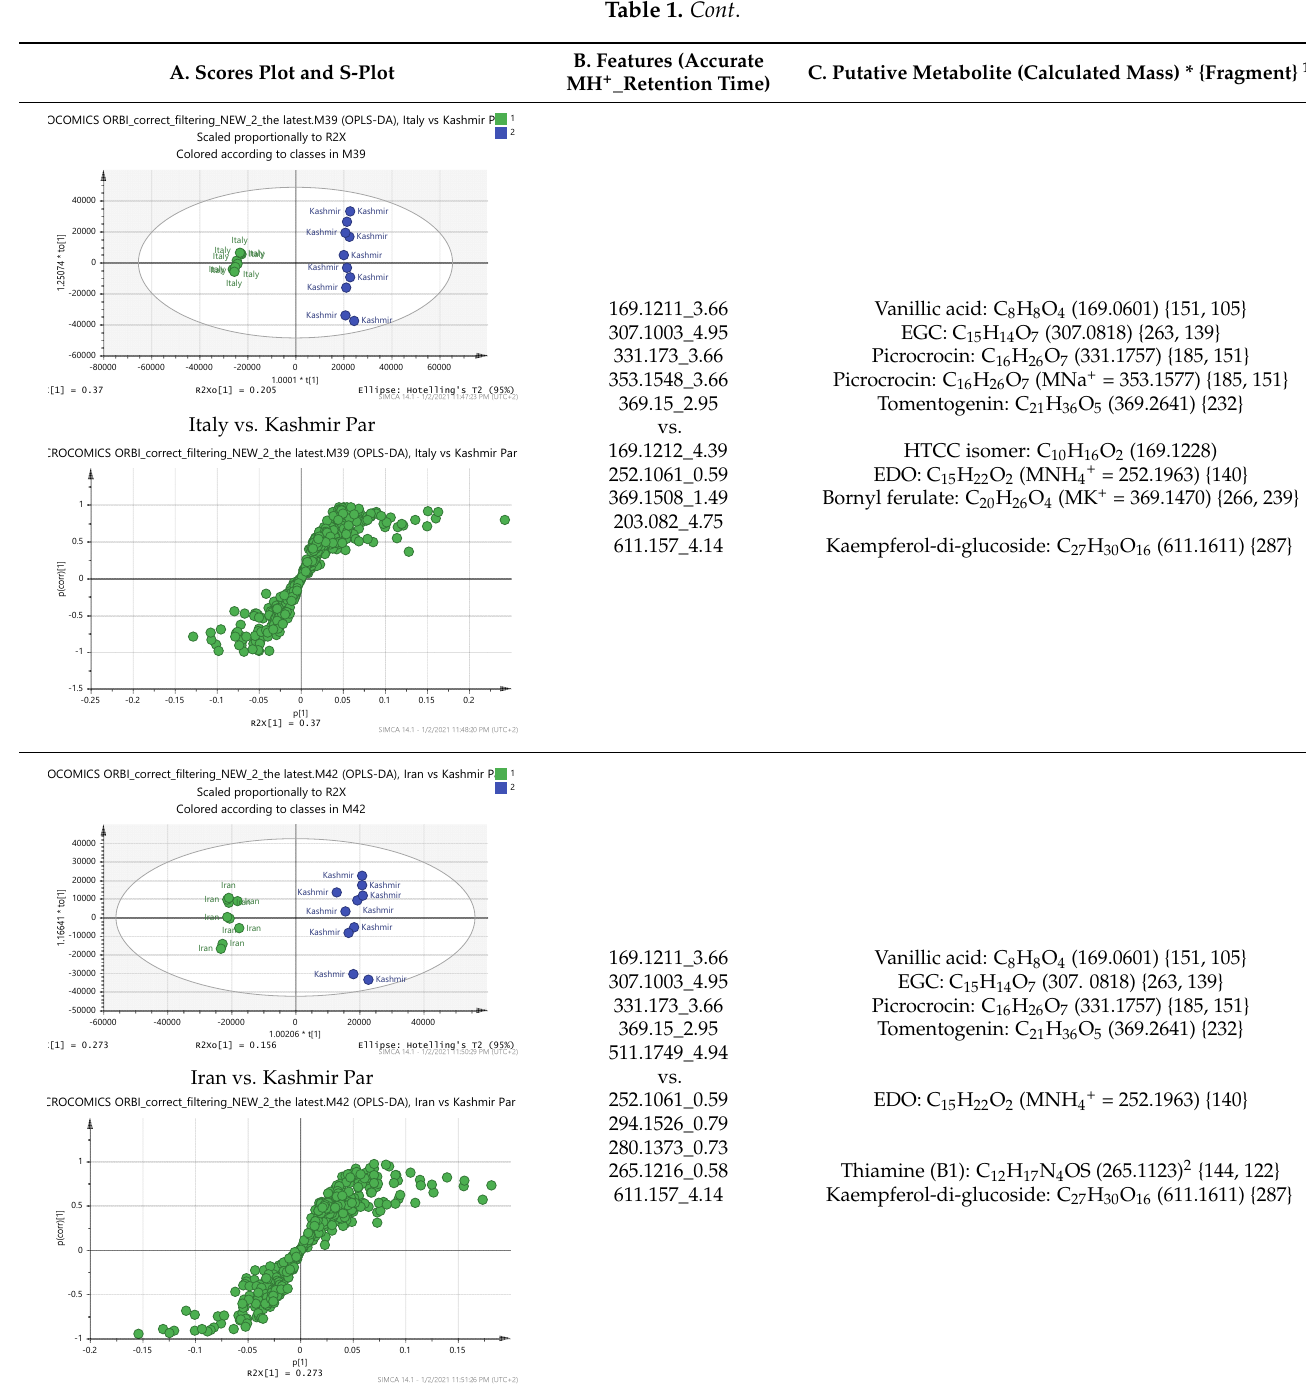
* The calculated mass values correspond to the protonated molecular ion (MH + ) ion or the adduct ion (e.g., with Na or K) shown in parenthesis. 1 The fragment ions for the selected precursor ions are shown in curly brackets. 2 In case of thiamine, the M + ion is observed instead of MH + , as the compound has a fixed positive charge. Abbreviations : HTCC: Hydroxy- β - cyclocitral; EGC: Epigallocatechin; EDO: